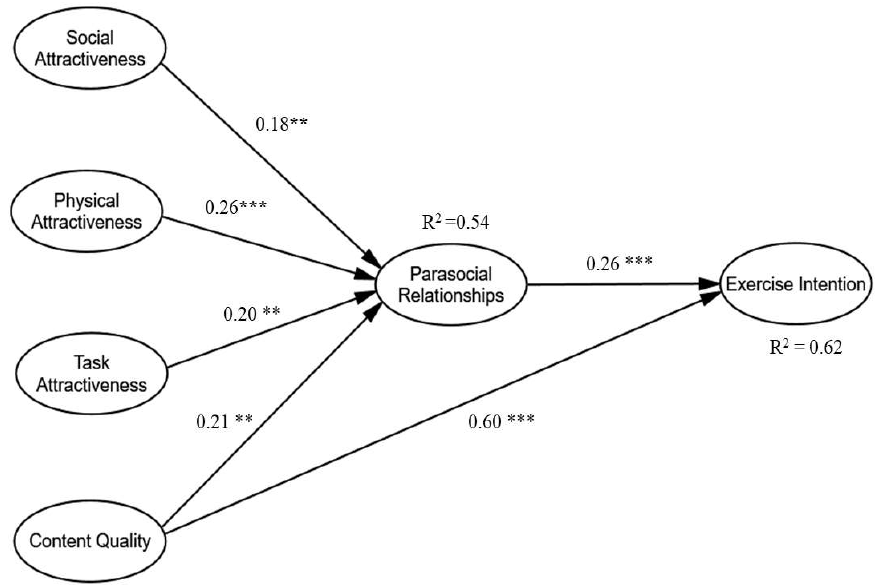
Figure 2. Results of structure model. ** p < 0.01; *** p < 0.001. Table 5. Hypotheses